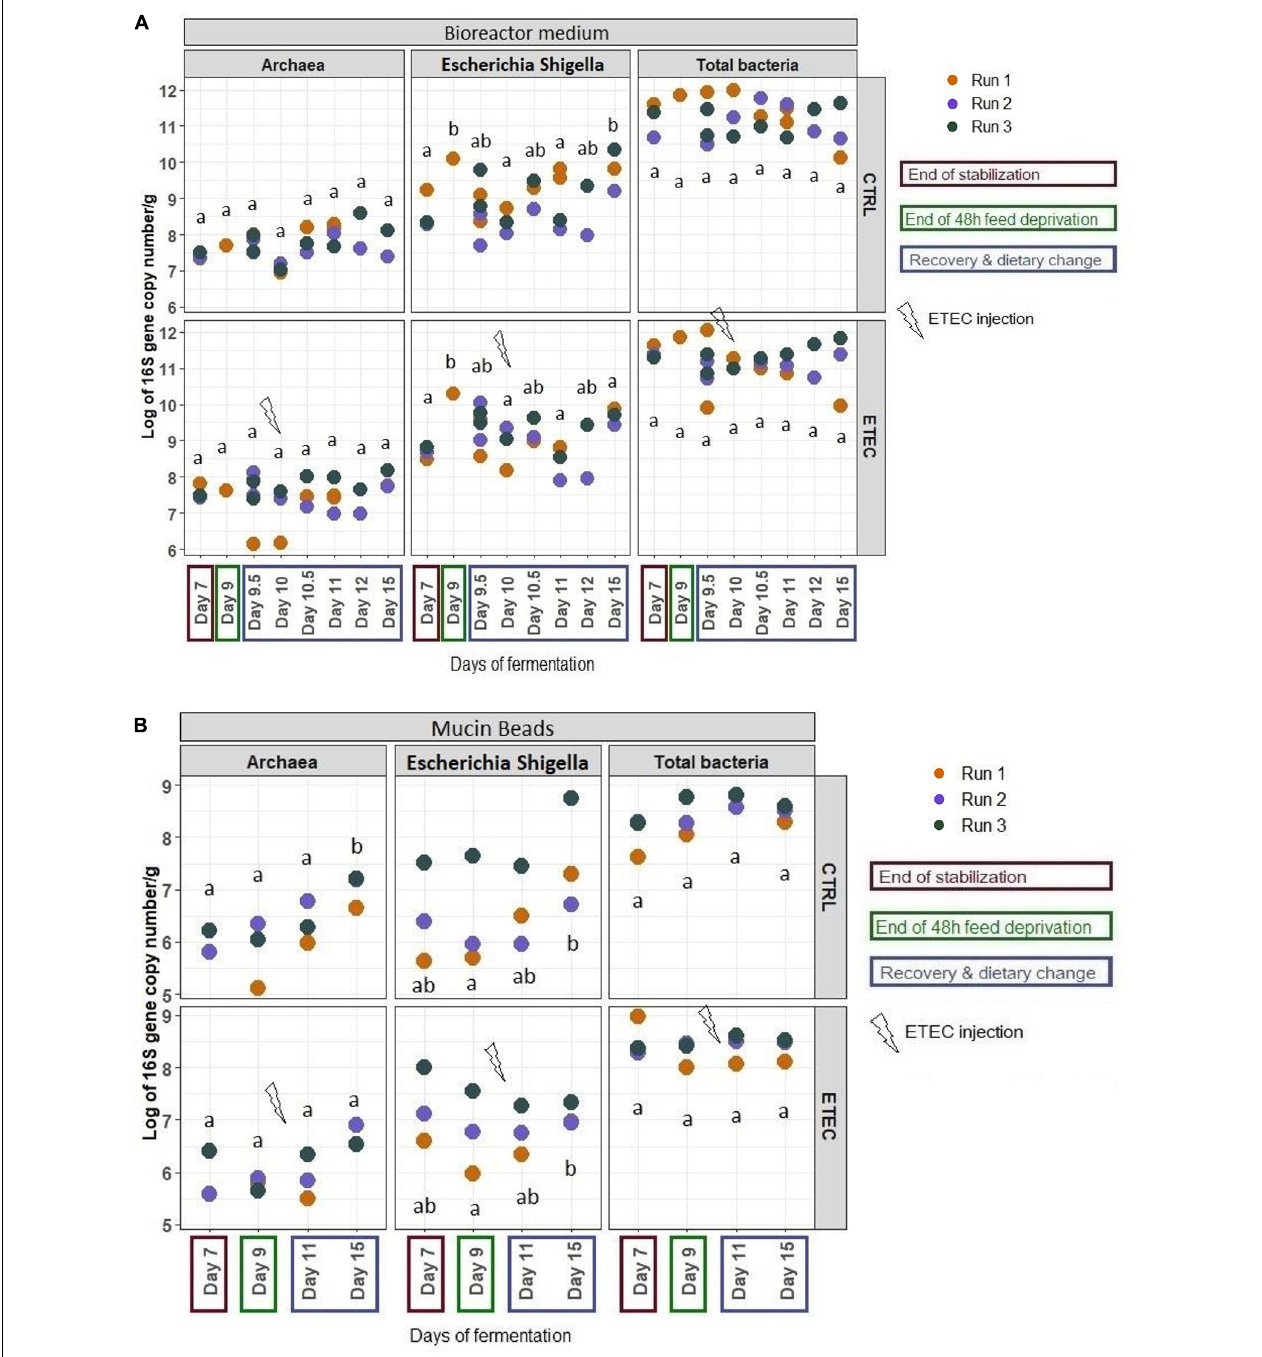
FIGURE 4 | Q -PCR quantification of total bacteria, Escherichia/Shigella and methanogenic archaea populations in the bioreactor medium (A) and the mucin beads (B) of the MPigut-IVM for the runs #1, 2, and 3 in the CTRL and ETEC conditions. The days sharing the same letters are not significantly different from each other ( p > 0.05) whatever the